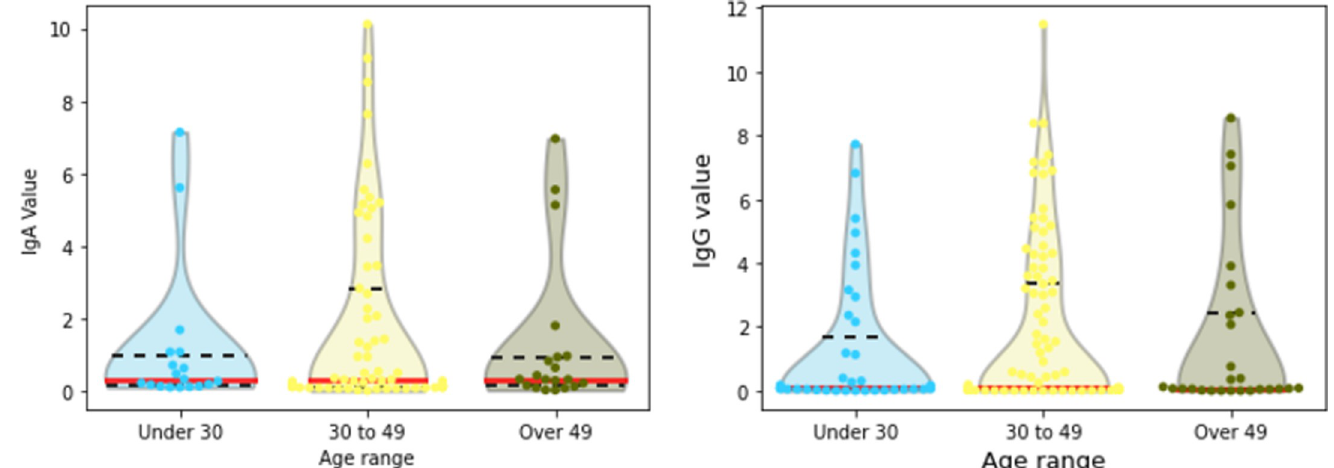
Fig 8. Violin plots of (a) IgA and (b) IgG among age groups; medians in solid red lines, third quartiles in dashed lines.